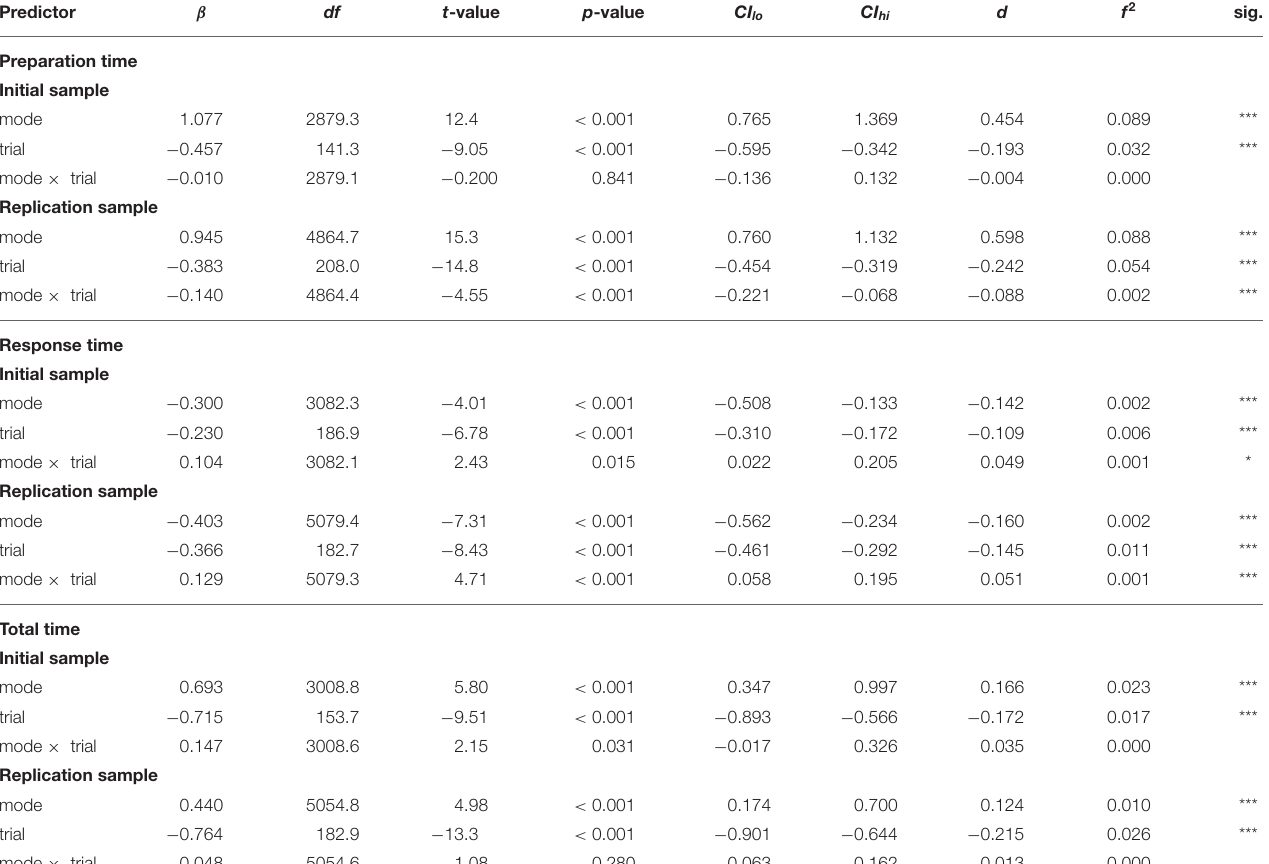
TABLE 3 | Summary of hierarchical linear modeling analyses for preparation time, response time, and total